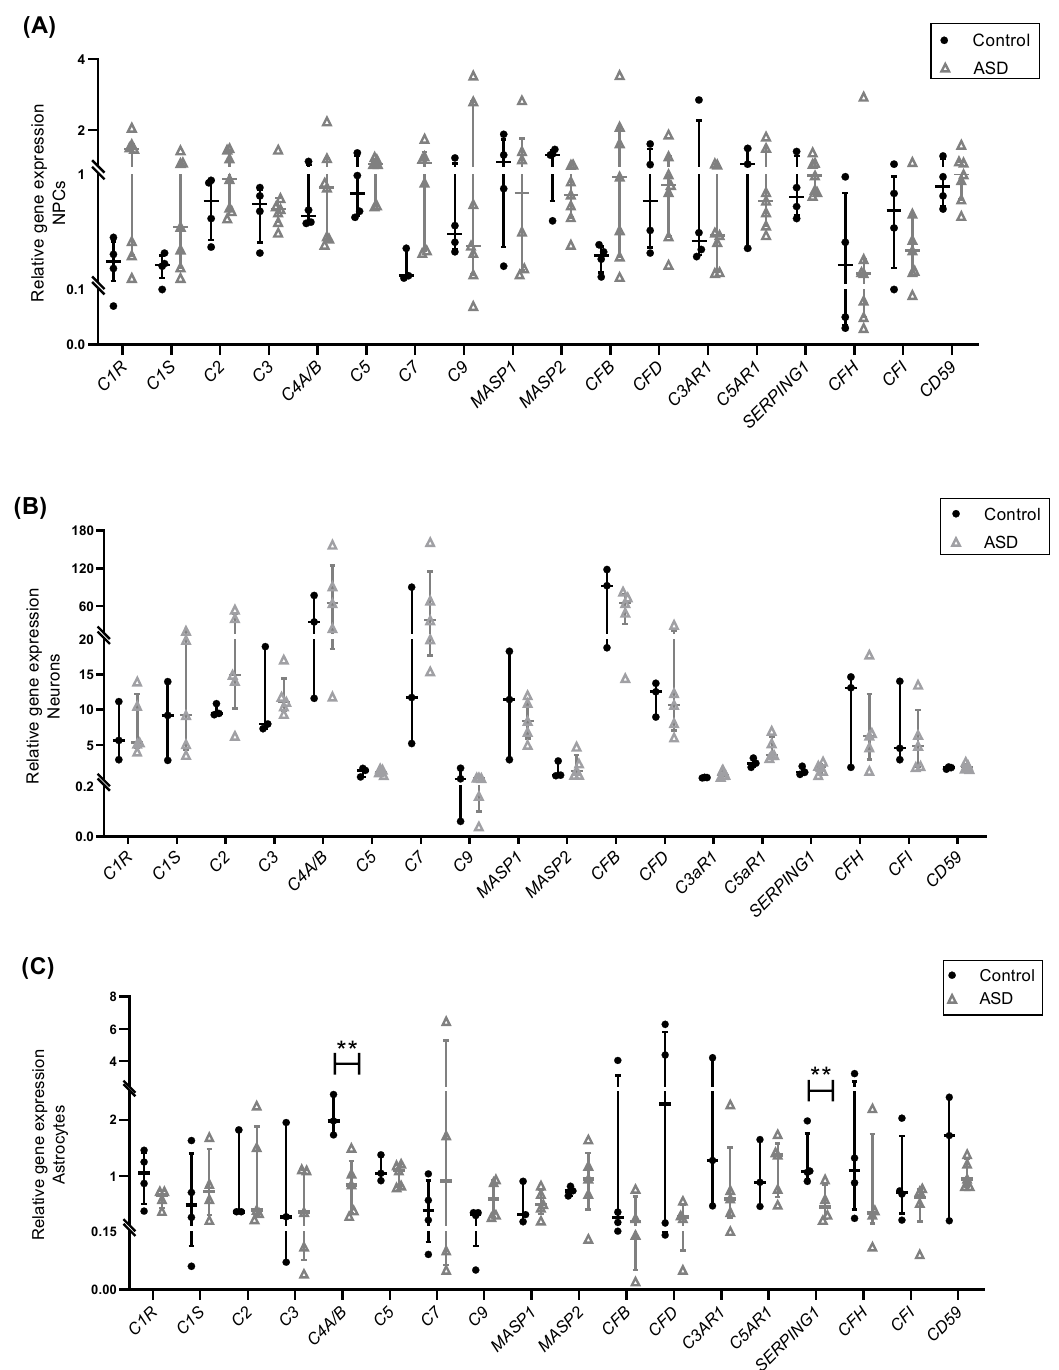
Figure 2. Expression of complement genes in iPSC-derived neural progenitor cells, neurons and astrocytes. Relative transcript levels of key complement system components, receptors, and regulators measured by RT-qPCR in: ( A ) iPSC-derived NPCs of control ( n = 4) and ASD ( n = 7) subjects; ( B ) iPSC-derived neurons of control ( n = 3) and ASD ( n = 5) subjects; ( C ) iPSC-derived astrocytes of control ( n = 4) and ASD ( n = 5) subjects. A significant decrease in the expression levels of C4A/B and SERPING1 mRNAs was observed in astrocytes derived from individuals with ASD compared to control astrocytes. ** p < 0.01.